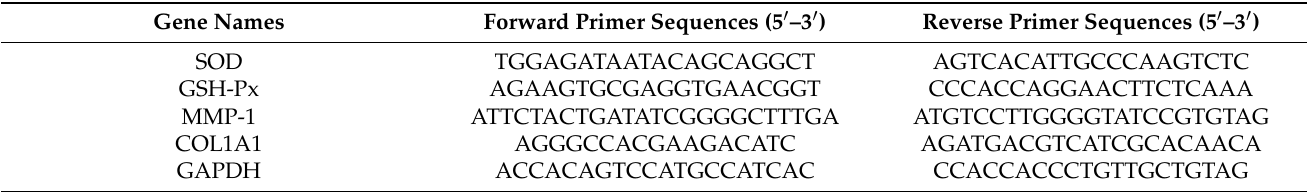
Table 3. Primer sequences for real-time PCR